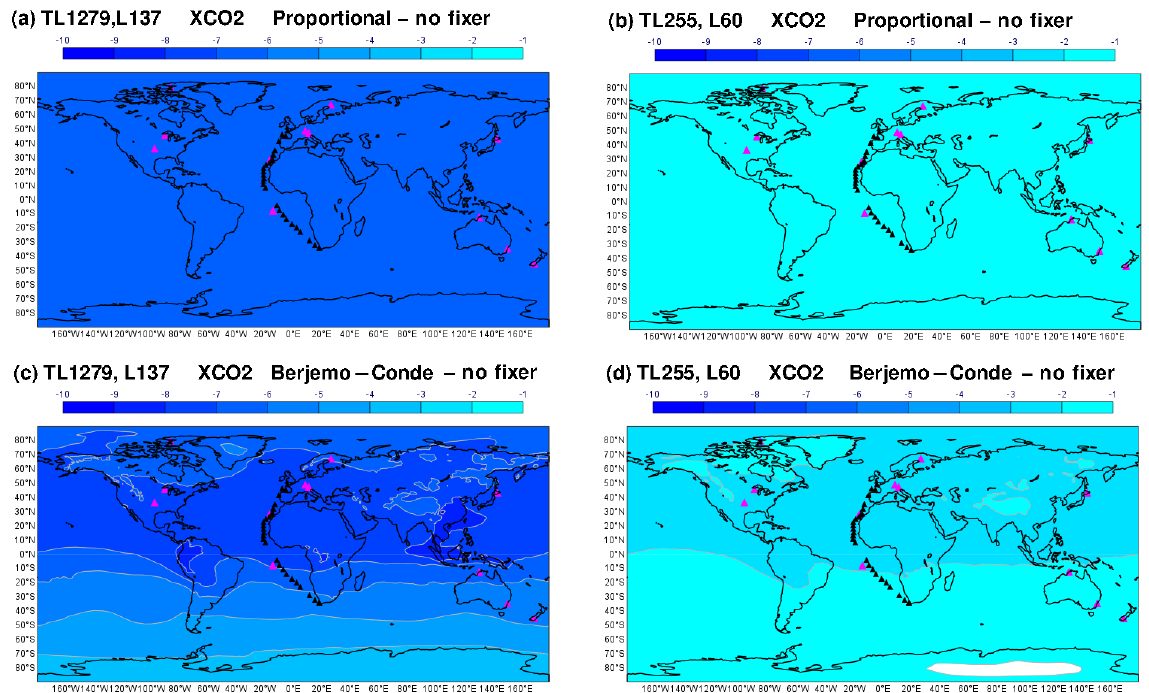
Figure 5. Difference in mean XCO 2 (ppm) between (a, b) the simulations using the proportional mass fixer and the simulation without mass fixer at high and low resolution respectively; (c, d) the simulation with Bermejo–Conde and the simulation without mass fixer at high and low resolutions respectively. The period covered and the marking of the observation sites are the same as in Fig. 3. See Table 2 for a list of the TCCON site coordinates. Table 3. XCO 2 inter-hemispheric gradient (IHG) error (MODEL − OBS) statistics for simulations with different resolution and different mass fixers with respect to observations from the Polarstern